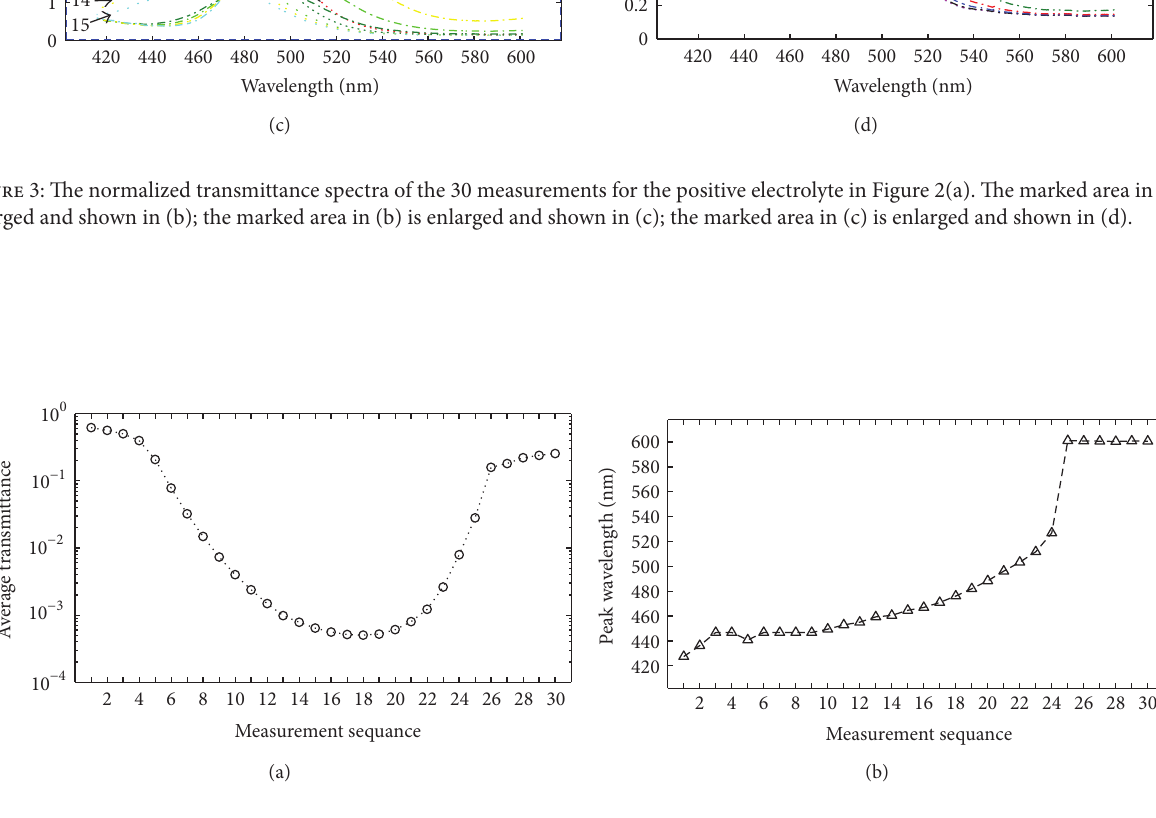
F 4: (a) e mean of the spectra of the 30 measurements for the positive electrolyte in Figure 3; (b) the peak wavelength within the measurement range (420nm–600nm) of the spectra of the 30 measurements for the positive electrolyte in Figure